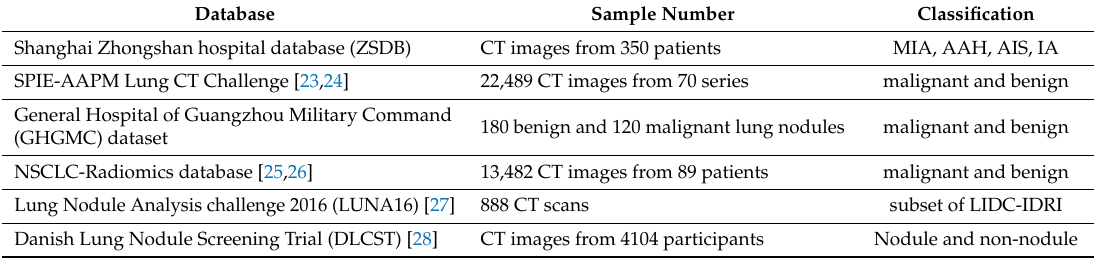
Table 3. Format of lung nodule